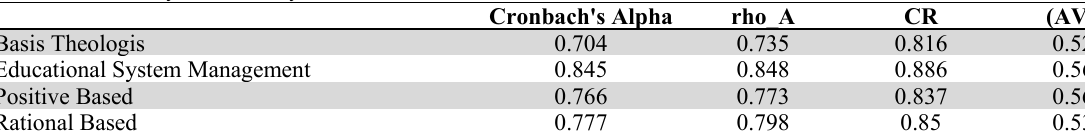
Construct Reliability and